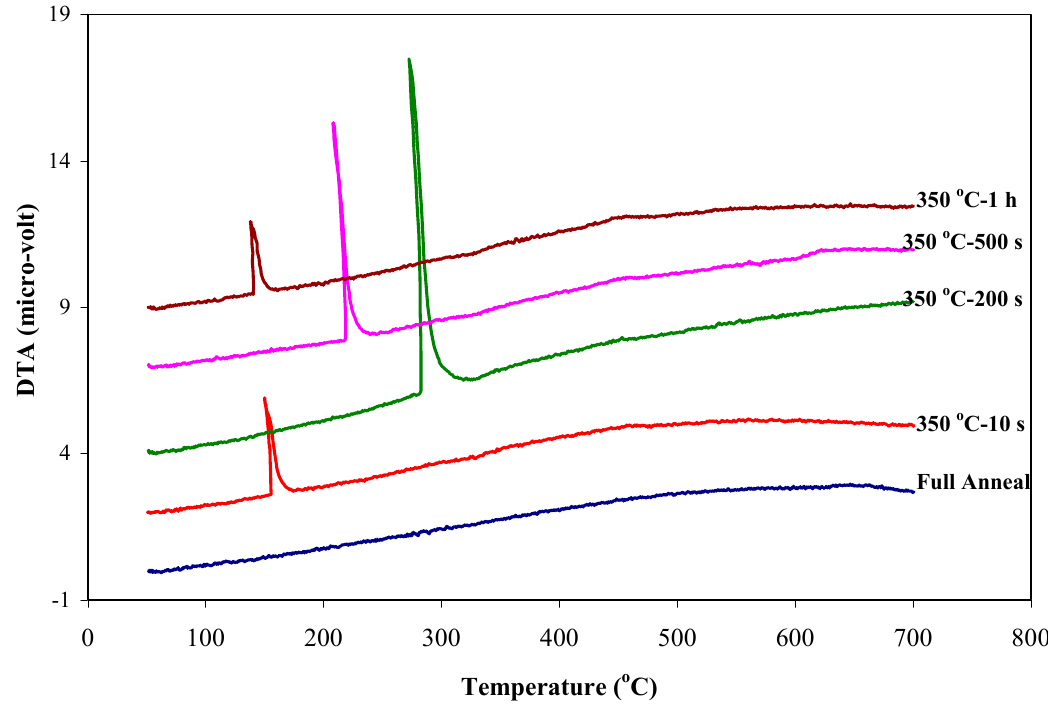
Figure 7. The DTA thermal curves taken from various Q&B heat-treated samples at 350 °C salt bath for different holding times in comparison to that of full annealed ones. Table 4. The summarized data of DTA for retained austenite decomposition temperature and its peak intensity in conjunction with the associated volume fraction and carbon concentration of various heat- treated samples.